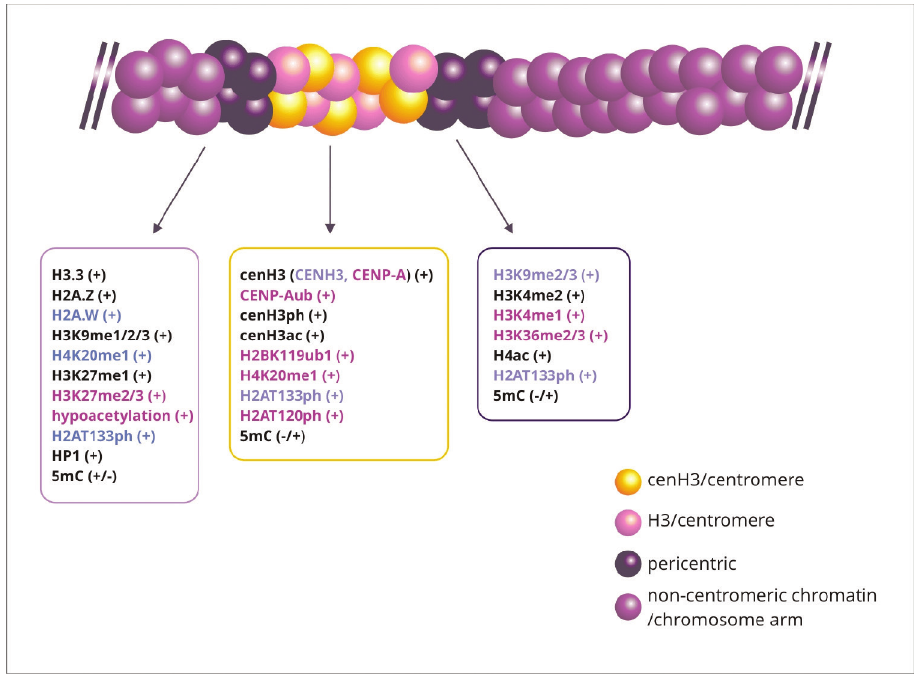
Figure 2. Epigenetic modifications in centromeric and pericentric chromatin. Centromeres consist of alternating blocks of nucleosomes containing H3 or cenH3. At pericentric sites, only H3-containing nucleosomes are present. Epigenetic markers in centomere and pericentromere regions characteristic for both plants and animals are marked with black color, only for plants with violet color, only for animals with rose color. (+) epigenetic marker always present; (-/+) epigenetic modification present or